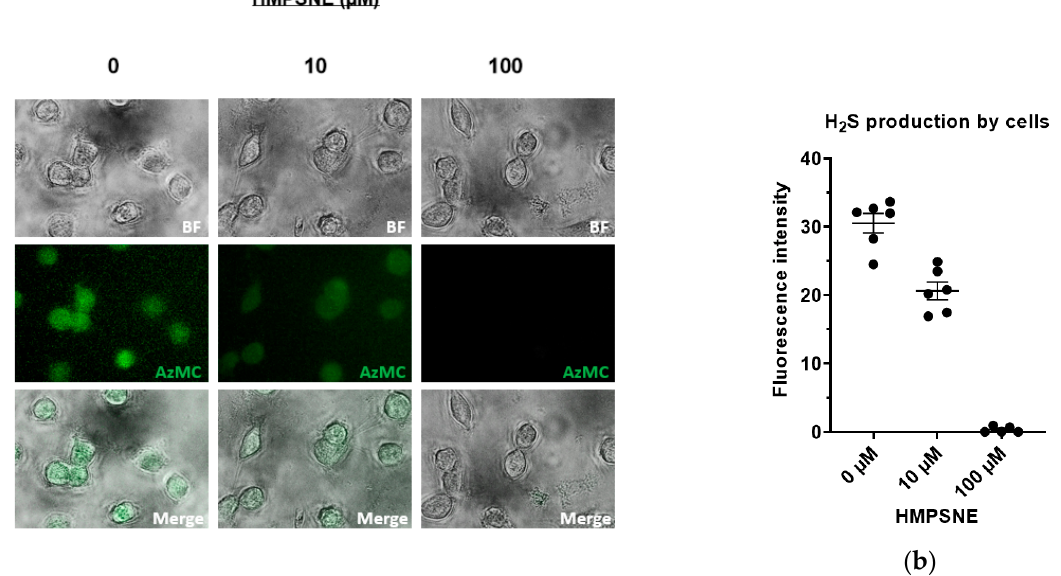
Figure 4. H 2 S production by live CT26 pretreated with HMPSNE: ( a ) CT26 cells were incubated 1 h with the probe AzMC after 3 h of incubation with HMPSNE at 10 µ M and 100 µ M or its vehicle. From top to bottom are brightfield, green channel and merged images taken with inverted microscope; ( b ) Quantification of fluorescence signal (analysis of the images was made using ImageJ). Single values are given by dots and corresponding mean ± SEM by lines.